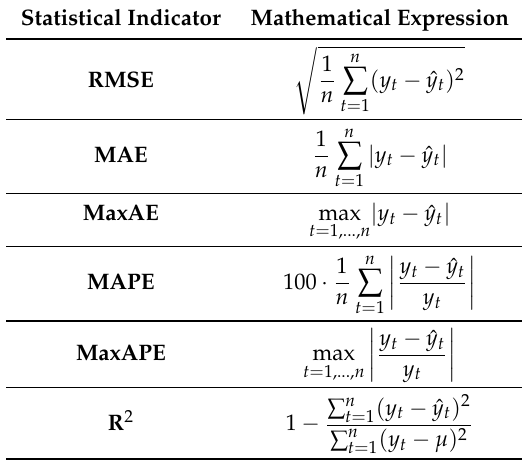
Table 1. Adopted Out-of-sample statistical indicators and their mathematical expressions. Statistical Indicator Mathematical